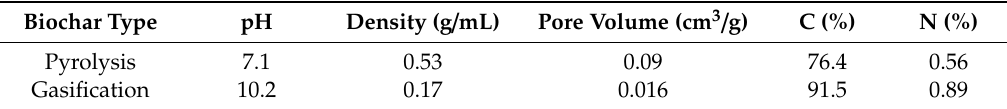
Table 1. The characteristics of